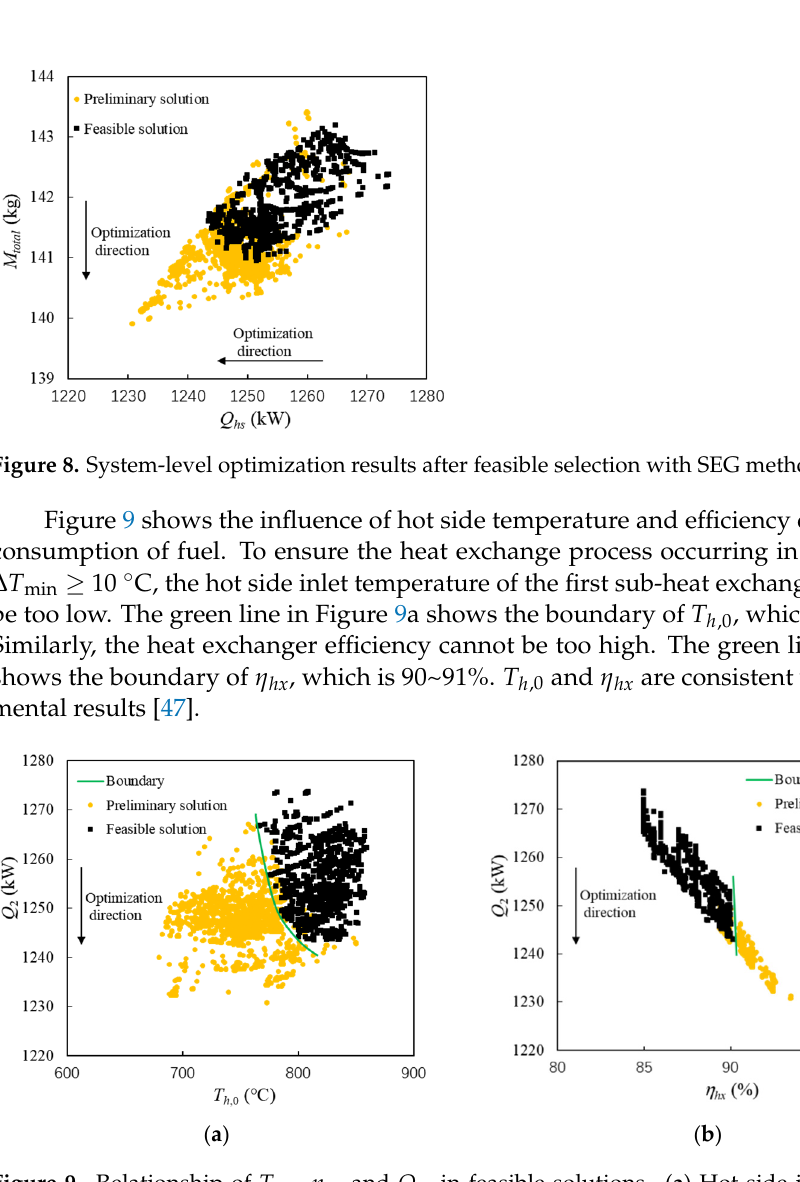
Figure 7. Heat exchange process of example point. ( a ) Variation curve of water equivalent with the temperature. ( b ) Temperature variation curve of sub-heat exchanger.